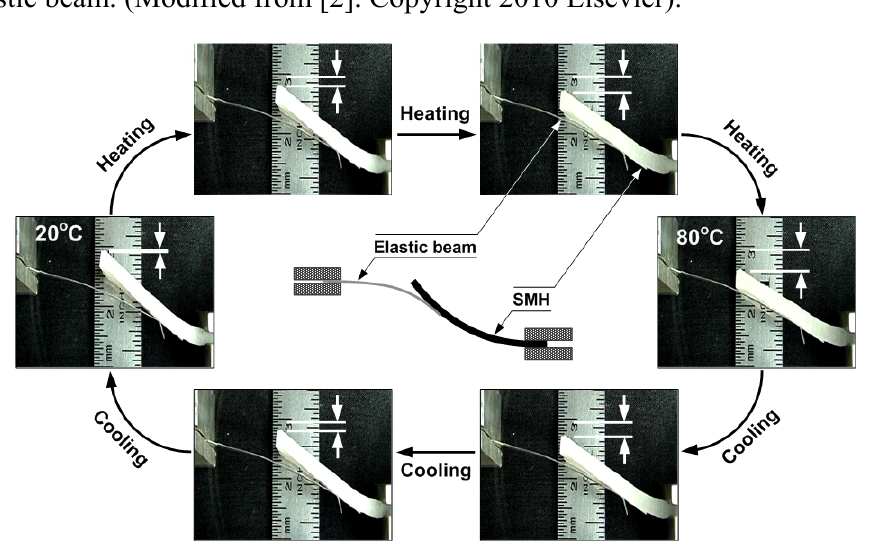
Figure 27. Reversible motion in silicone–PW–GF hybrid beam upon thermal cycling against a thin elastic beam. (Modified from [2]. Copyright 2010